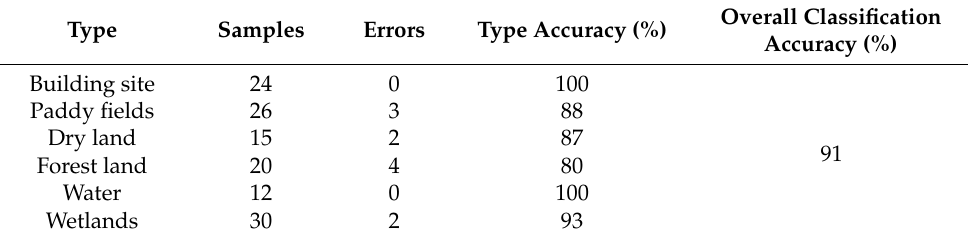
Table 2. Classification accuracy of all types for remote-sensing images in the Sanhuanpao